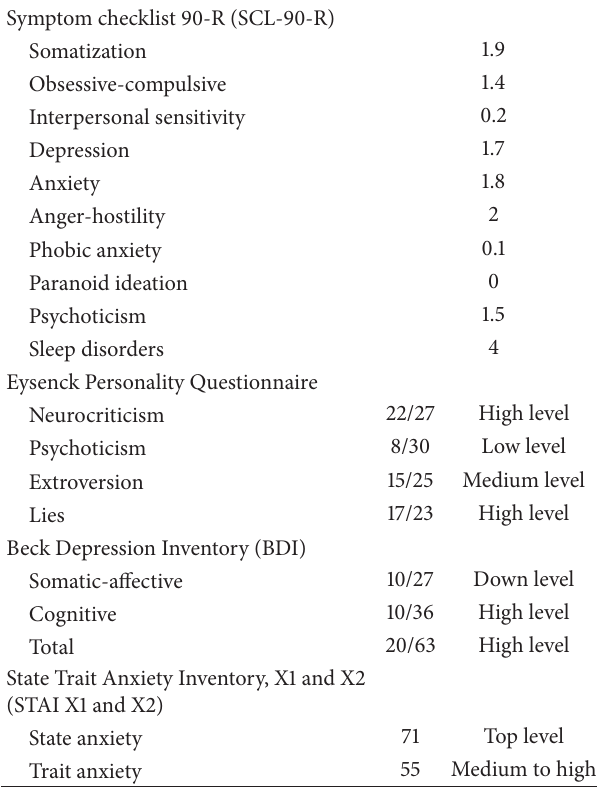
Table 1: Scores obtained by the patient on psychological